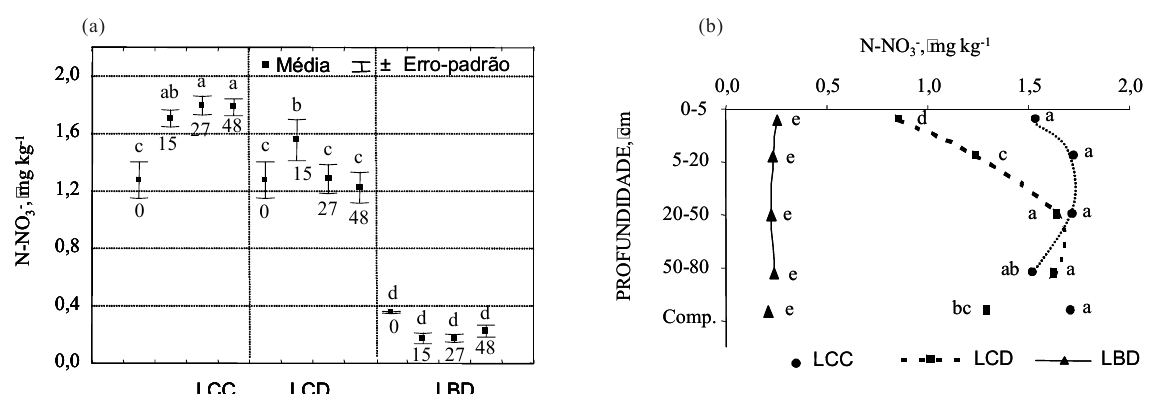
Figura 3. Teores de N-NO 3- nos diferentes tipos de lodo de acordo com: (a) os tempos de incubação de 0, 15, 27 e 48 dias; (b)